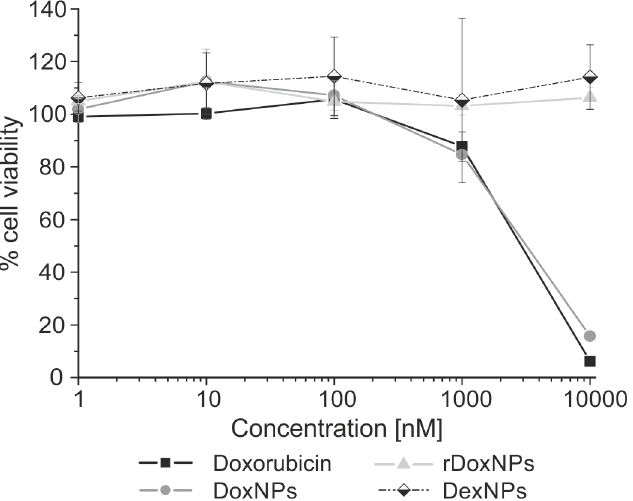
Fig 9. HeLa cell viability after 24h incubation with doxorubicin, Dex-NPs, Dox-NPs and